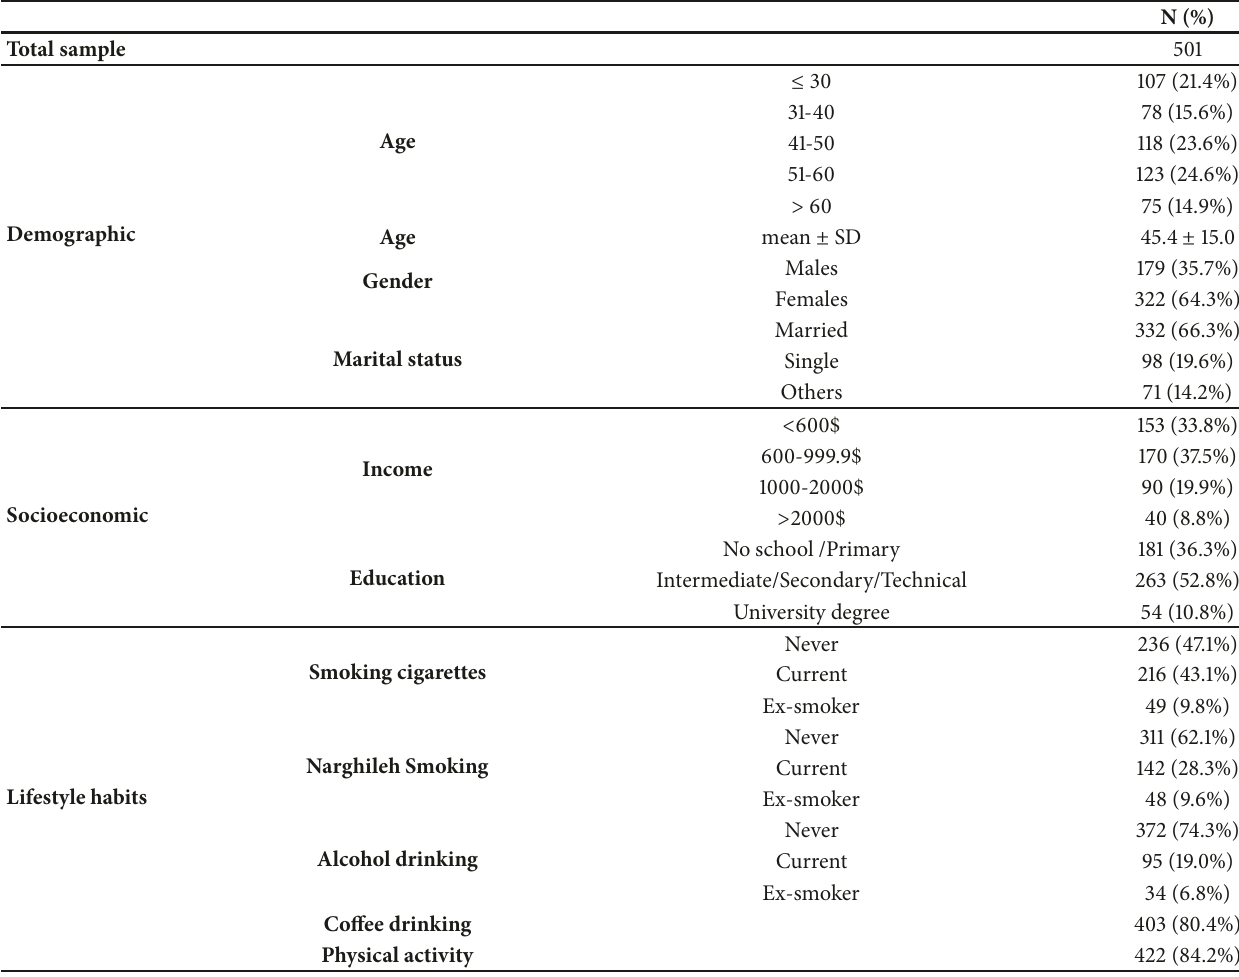
Table 1: Baseline characteristics of the study